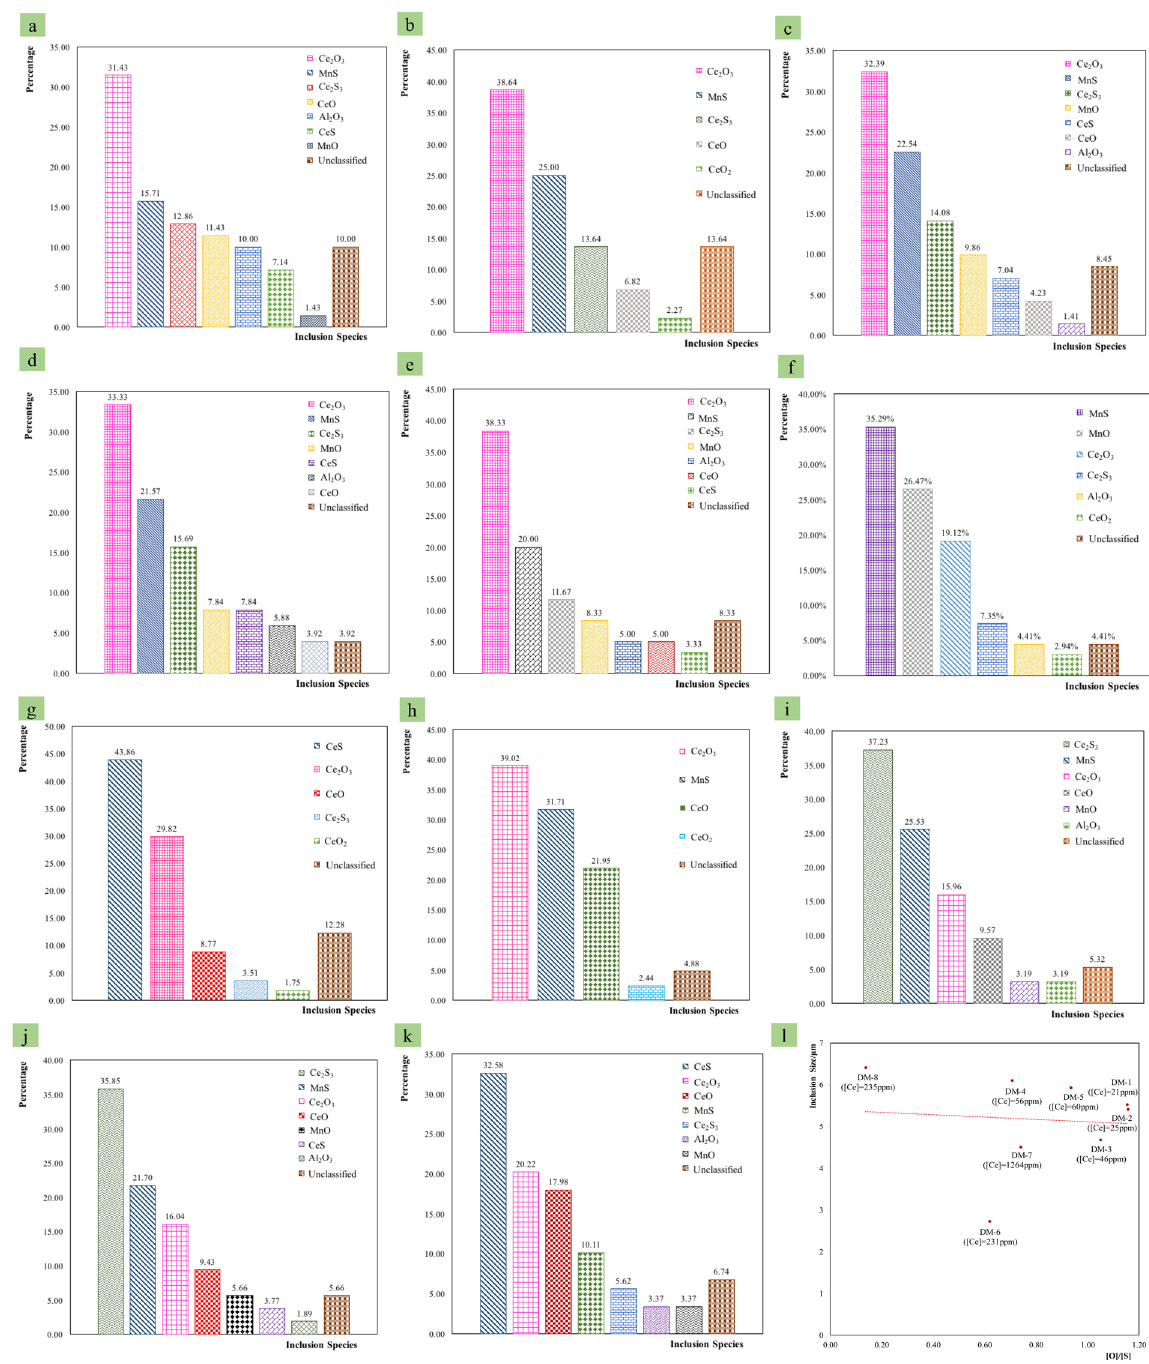
Figure 1. ( a – h ) Inclusion species distribution of different samples during furnace-cooling to room temperature; ( i – k ) inclusion species distribution for sample DM-2, DM-5 and DM-7 after quenching at 1673 K; (l) inclusion size distribution affected by oxygen to sulfur ratios of different samples during furnace-cooling to room